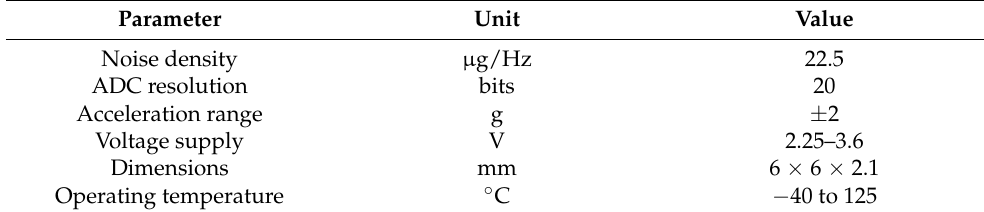
Table 1. Basic parameters of ADXL355 accelerometer